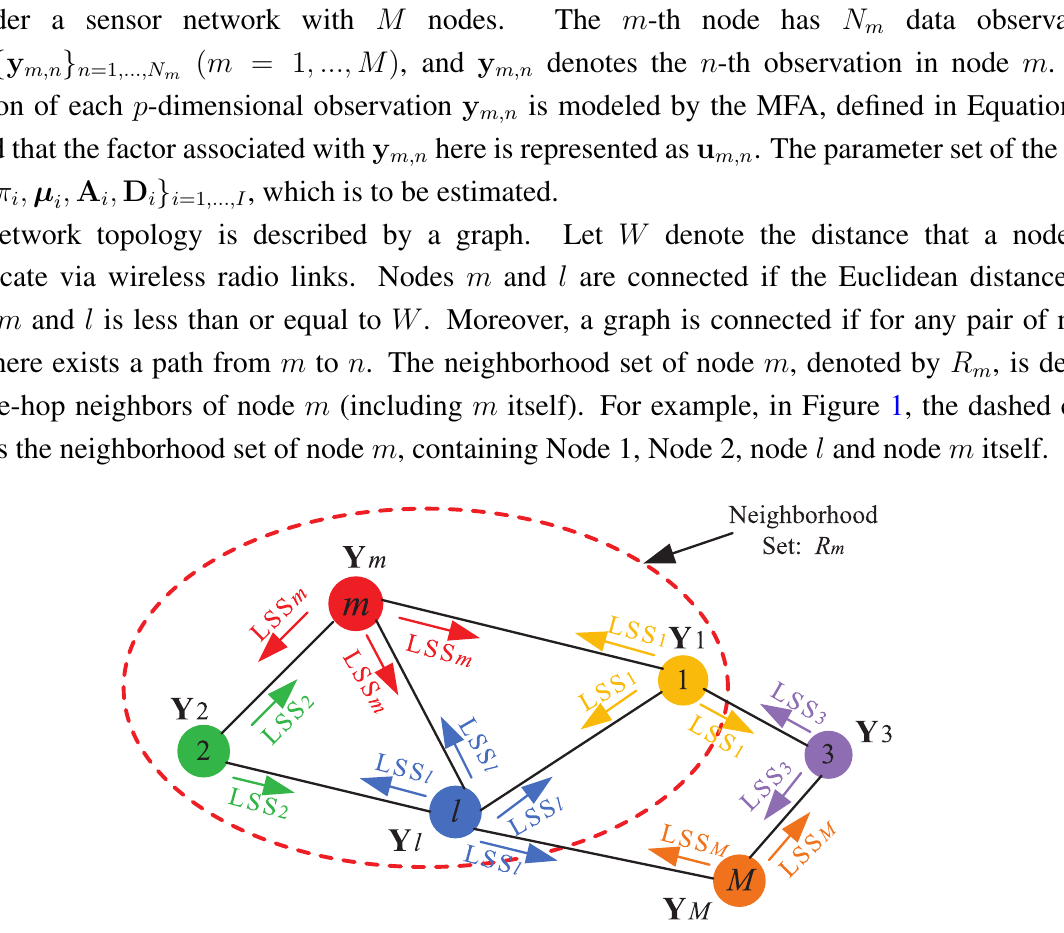
A sensor network consists of a collection of cooperating nodes. Node m only exchanges information (e.g., local sufficient statistics (LSS) in the proposed D-MFA and D-M t FA algorithms) with nodes in R m